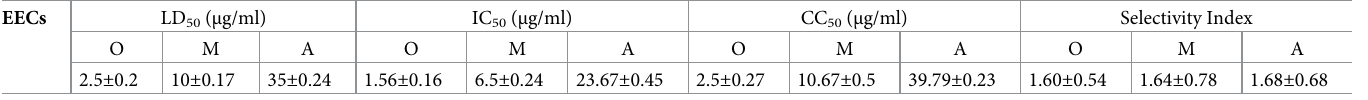
Table 2. Evaluation of the antifilarial activity of polyphenol-rich ethanolic extract (EECs) of Cajanus scarabaeoides . EECs LD 50 ( μ g/ml)